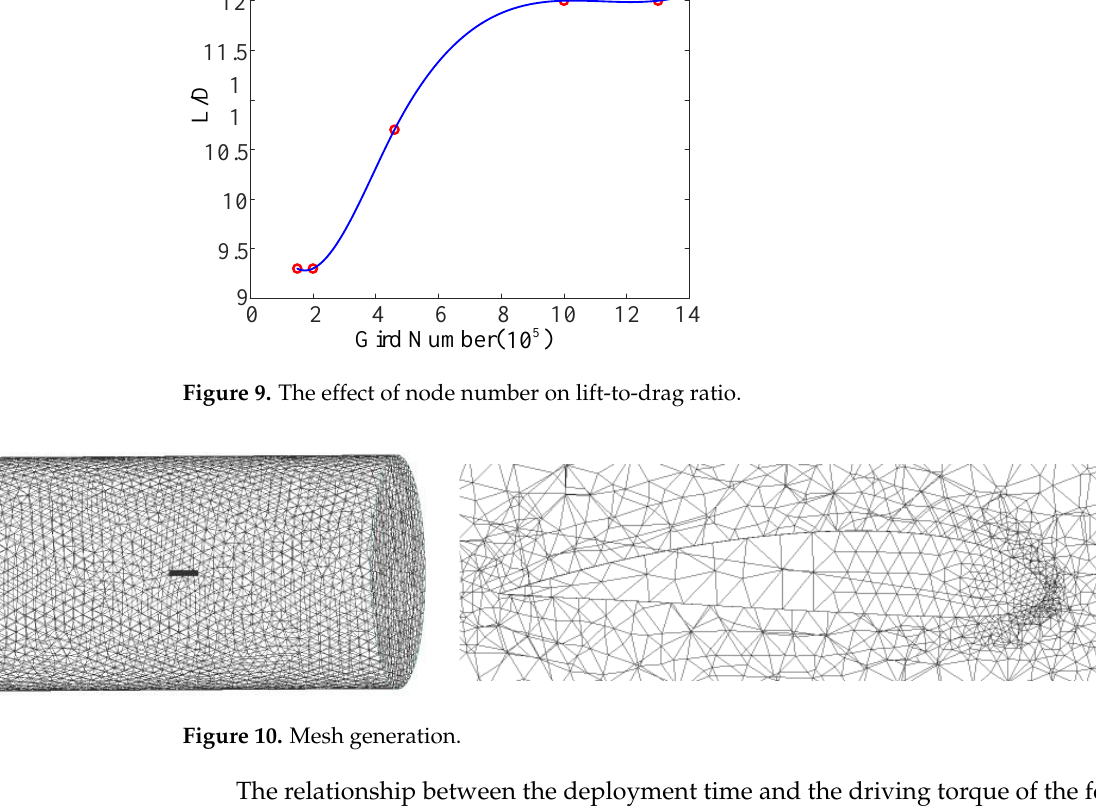
Figure 9. The effect of node number on lift-to-drag ratio.